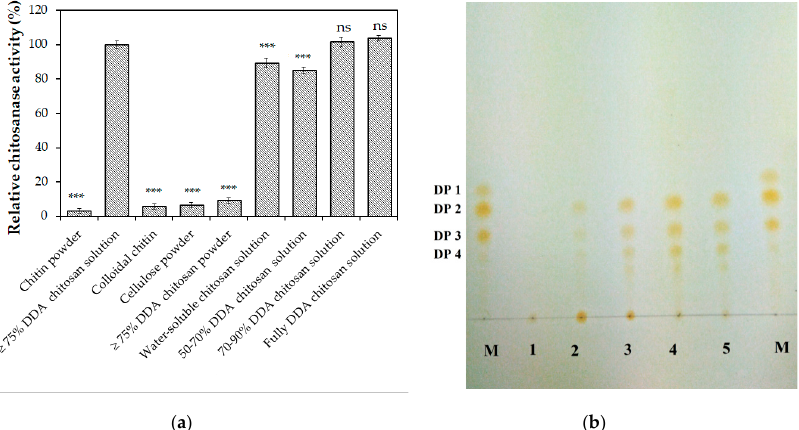
Figure 5. Substrates specificity of Paenibacillus sp. TKU047 chitosanase ( a ) and thin-layer chromatography (TLC) profile of hydrolysis products of 98% degree of deacetylation (DDA) chitosan by the purified enzyme ( b ). All data points were the mean and standard deviation. Note: ns, *** were not significantly different, or significantly different at p < 0.001 (respectively). The activity of the enzyme on ≥ 75% DDA chitosan solution was used as the control group. M: (GlcN) 1-4 ; 1-6: the hydrolysis solutions were taken at 0 min, 30 min, 60 min, 120 min, and 180 min, respectively.